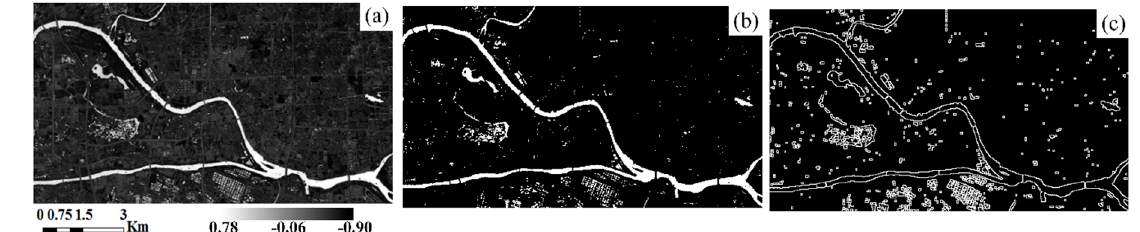
Figure 5. Pure water and mixed water-land pixels for Region C: ( a ) normalized difference water index (NDWI) image of green and SWIR1 bands; ( b ) pure water pixels (white) of NDWI with a 0.101 threshold; and ( c ) mixed water-land pixels (white).